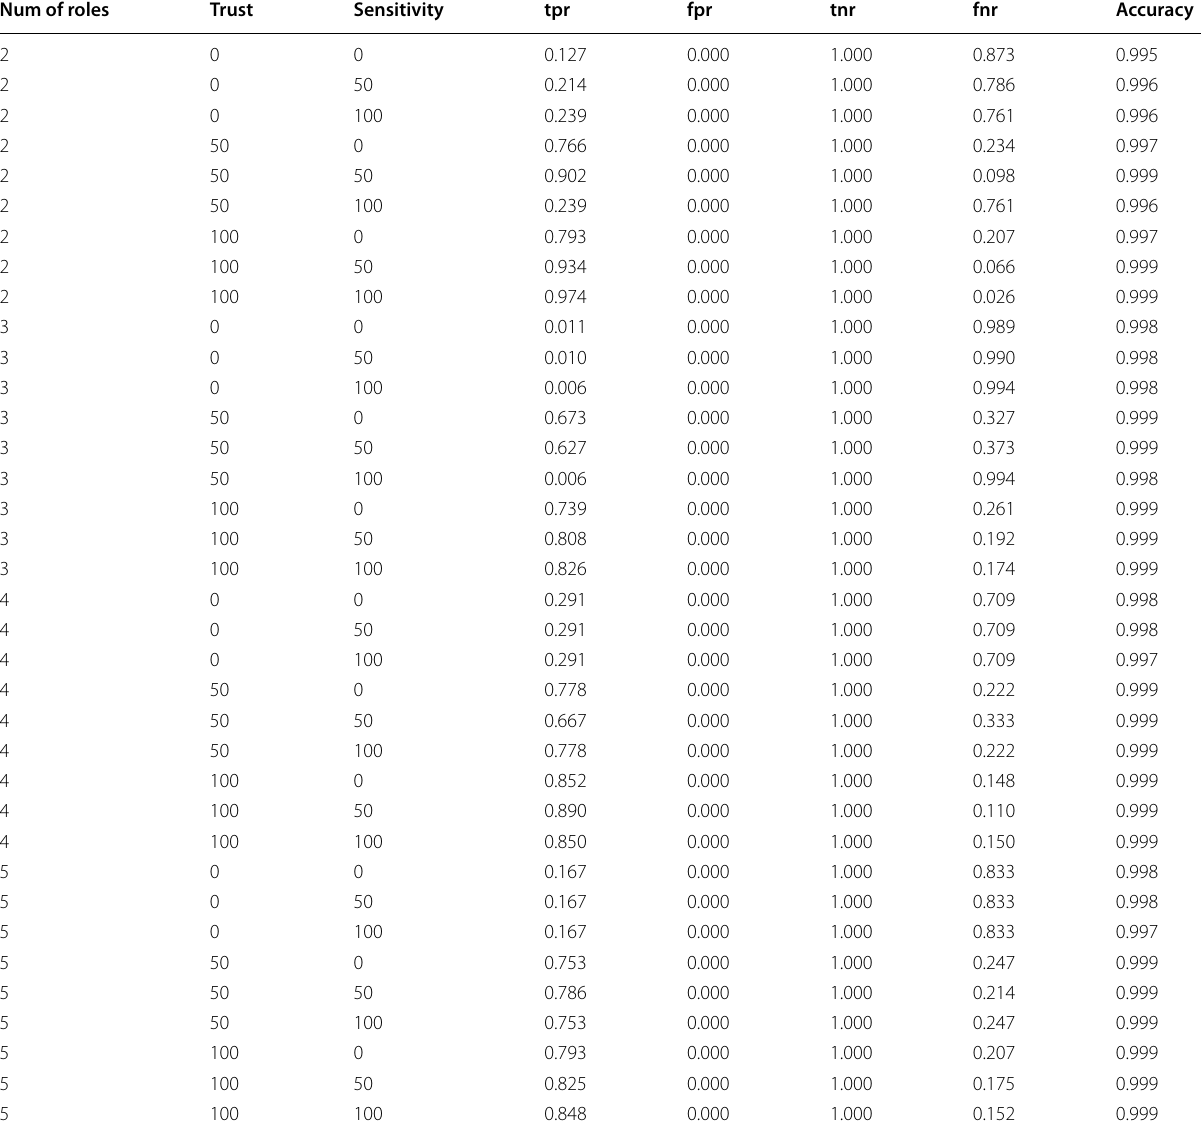
Table 5 Average accuracy values by trust and sensitivity Num of roles Trust